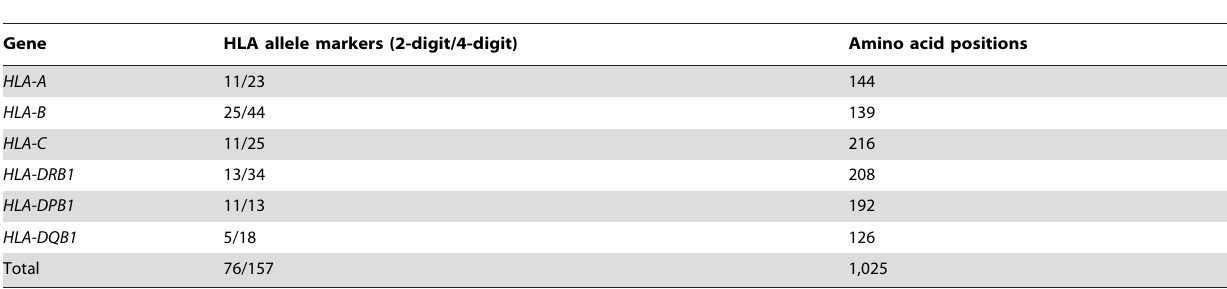
Table 1. Number of classical HLA alleles and polymorphic amino acid positions in the HLA reference panel.